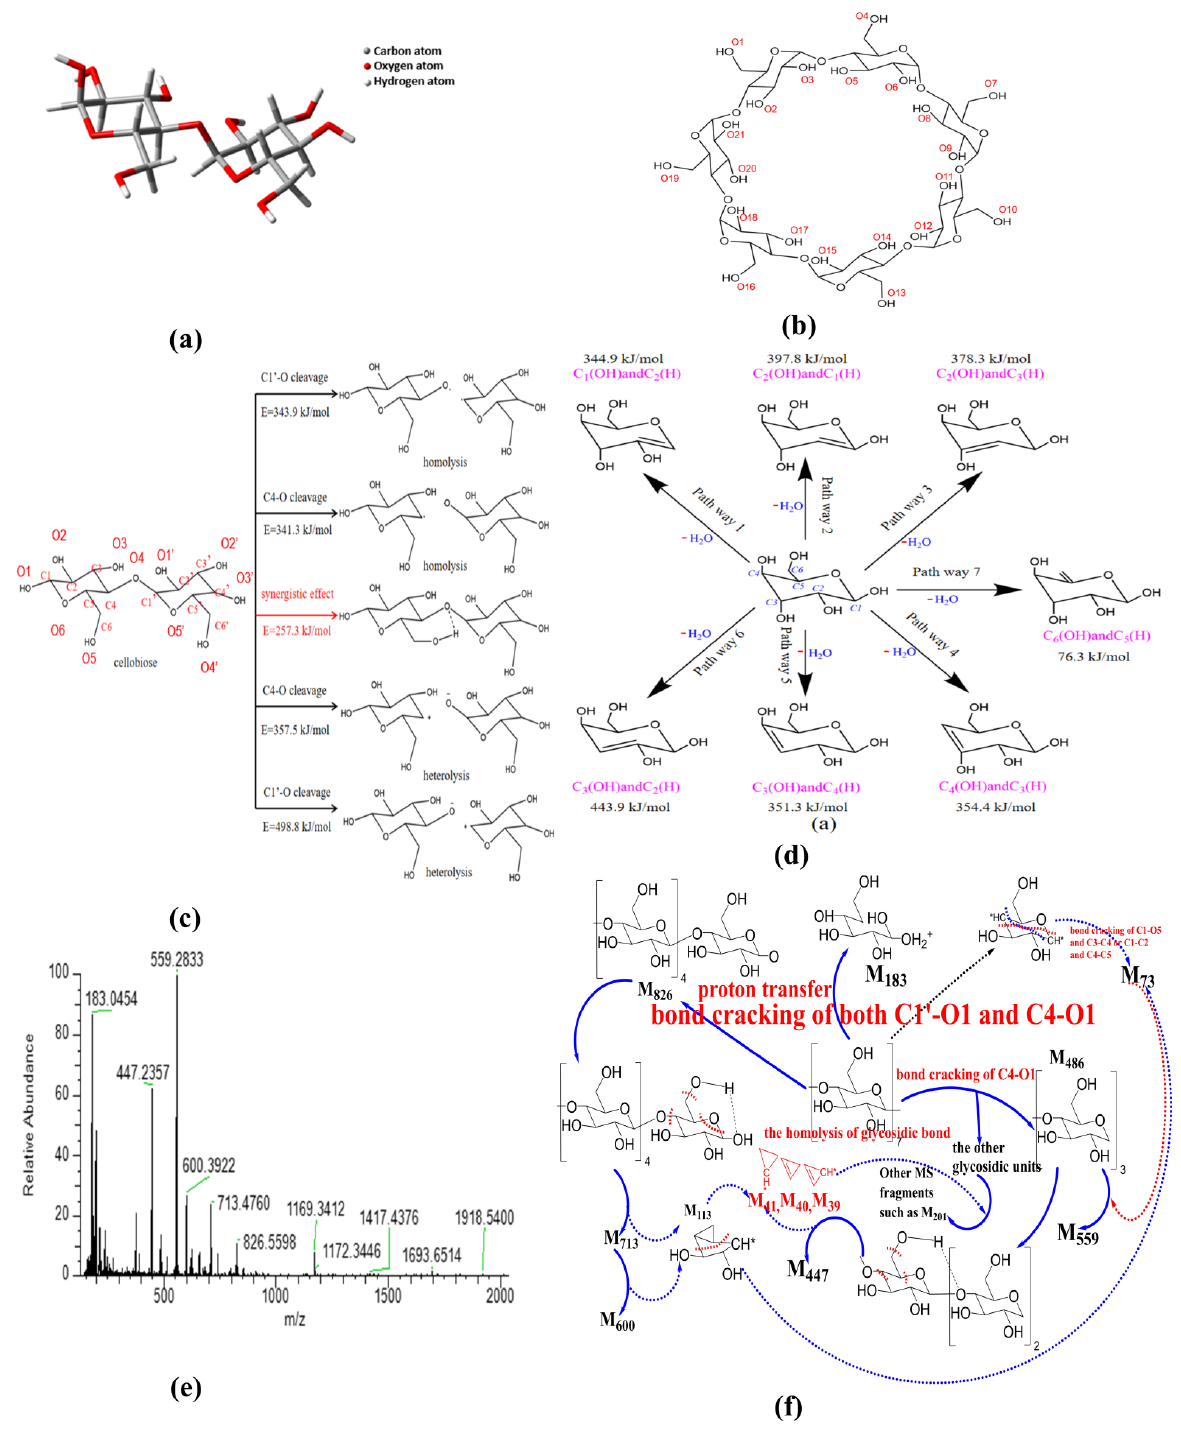
Figure 4. Mechanism analysis of thermal activation of β -CD (( a ) cellobiose structure; ( b ) β -CD structure; ( c) fracture process of glycosidic bond; ( d ) dehydration of pyranose; ( e ) MS spectra; ( f ) cracking of β -CD).